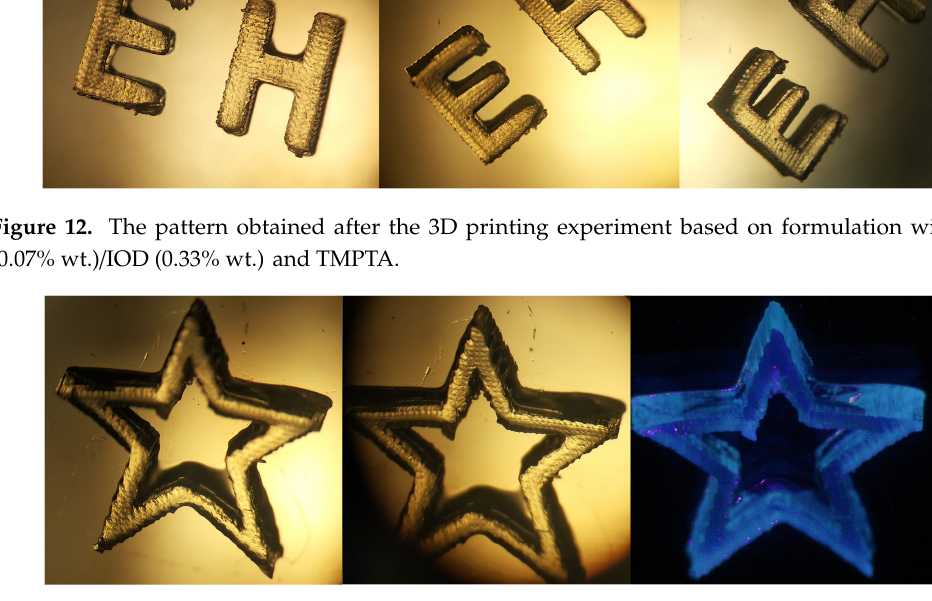
Figure 13. The pattern obtained after the 3D printing experiment based on formulation with T1 (0.07% wt.)/EDB (0.5% wt.) and TMPTA.